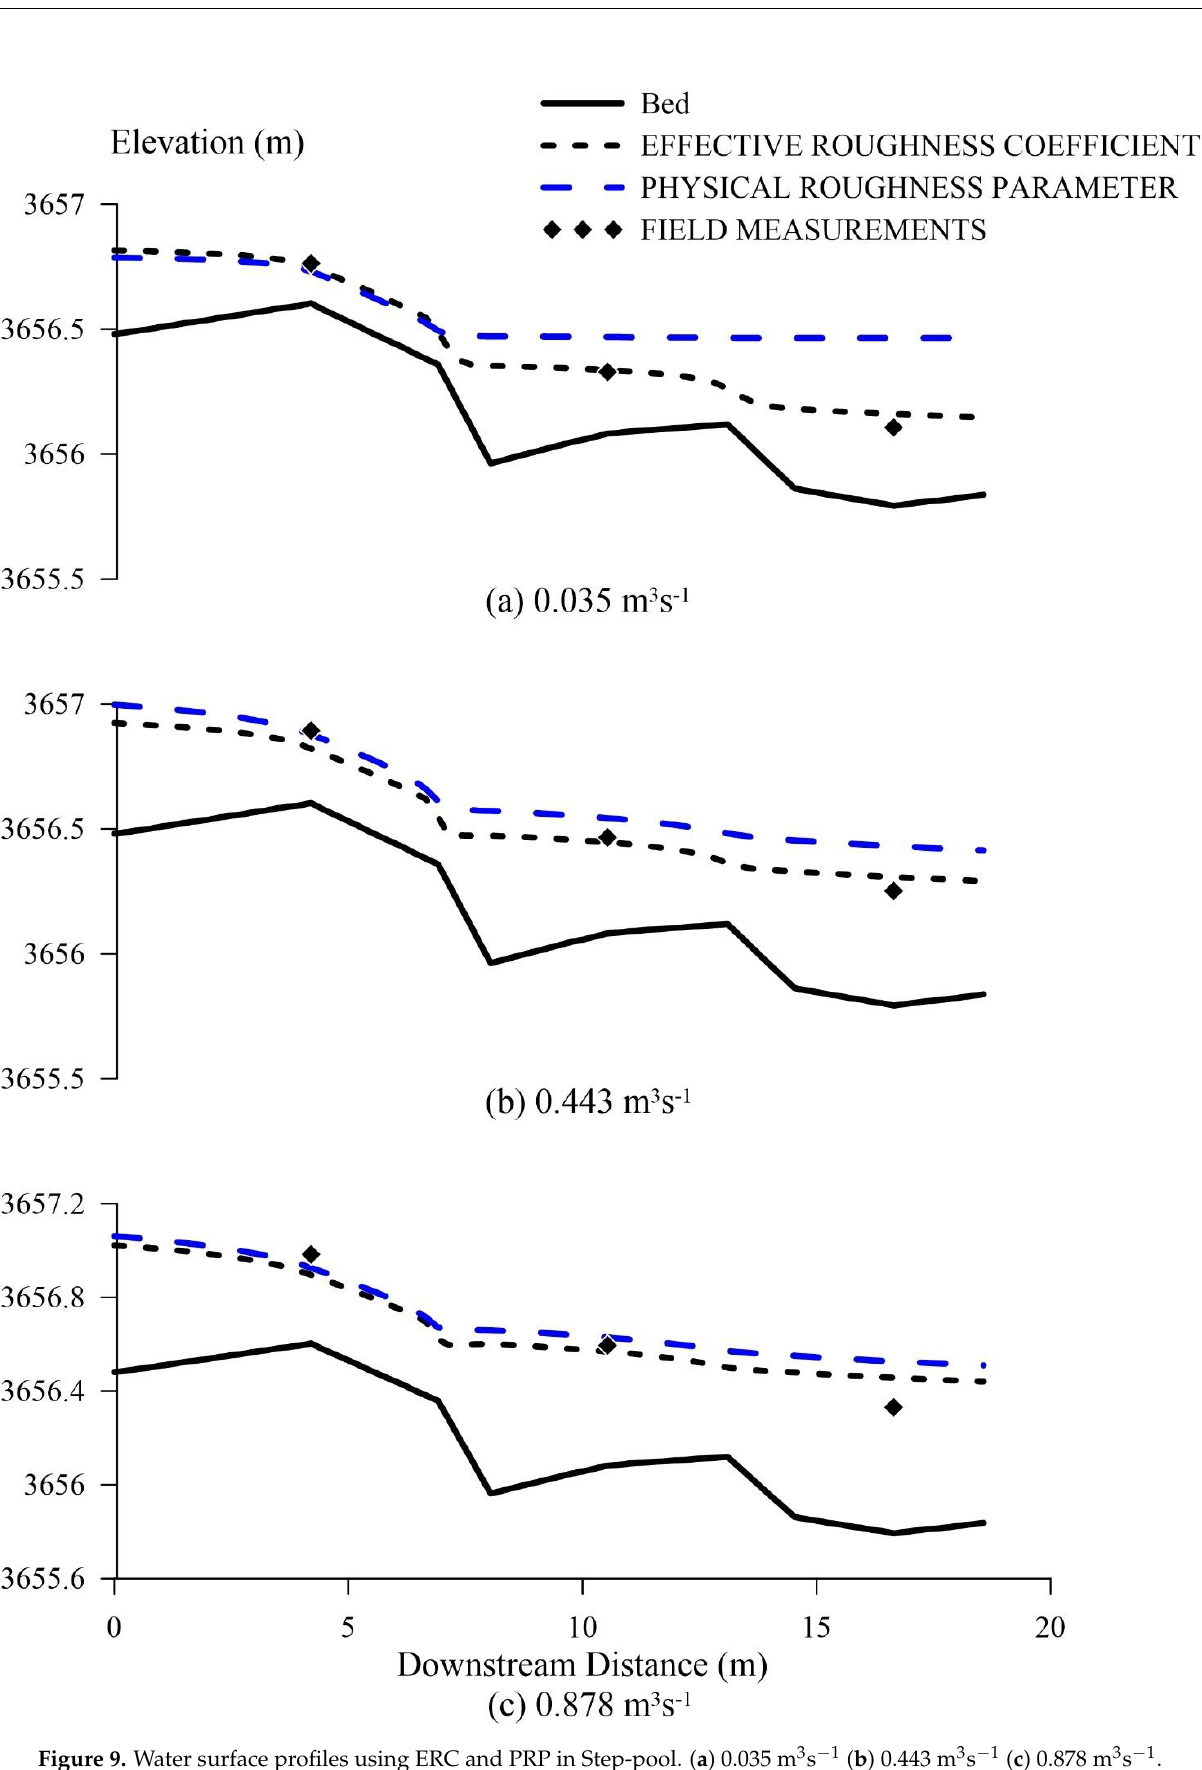
Figure 9. Water surface profiles using ERC and PRP in Step-pool. ( a ) 0.035 m 3 s −1 ( b ) 0.443 m 3 s −1 ( c ) 0.878 m 3 s −1 .